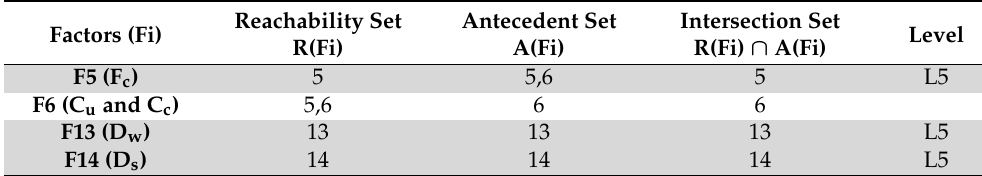
Table A7. Level partition—Iteration 5.